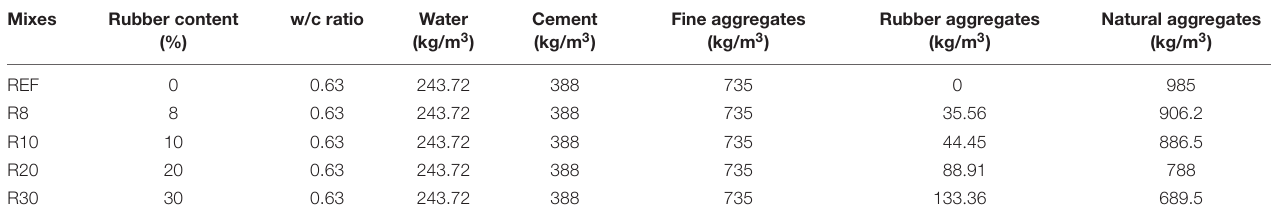
FIGURE 2 | Grain size distribution of different types of aggregates. TABLE 1 | Material composition for reference and rubberized concrete